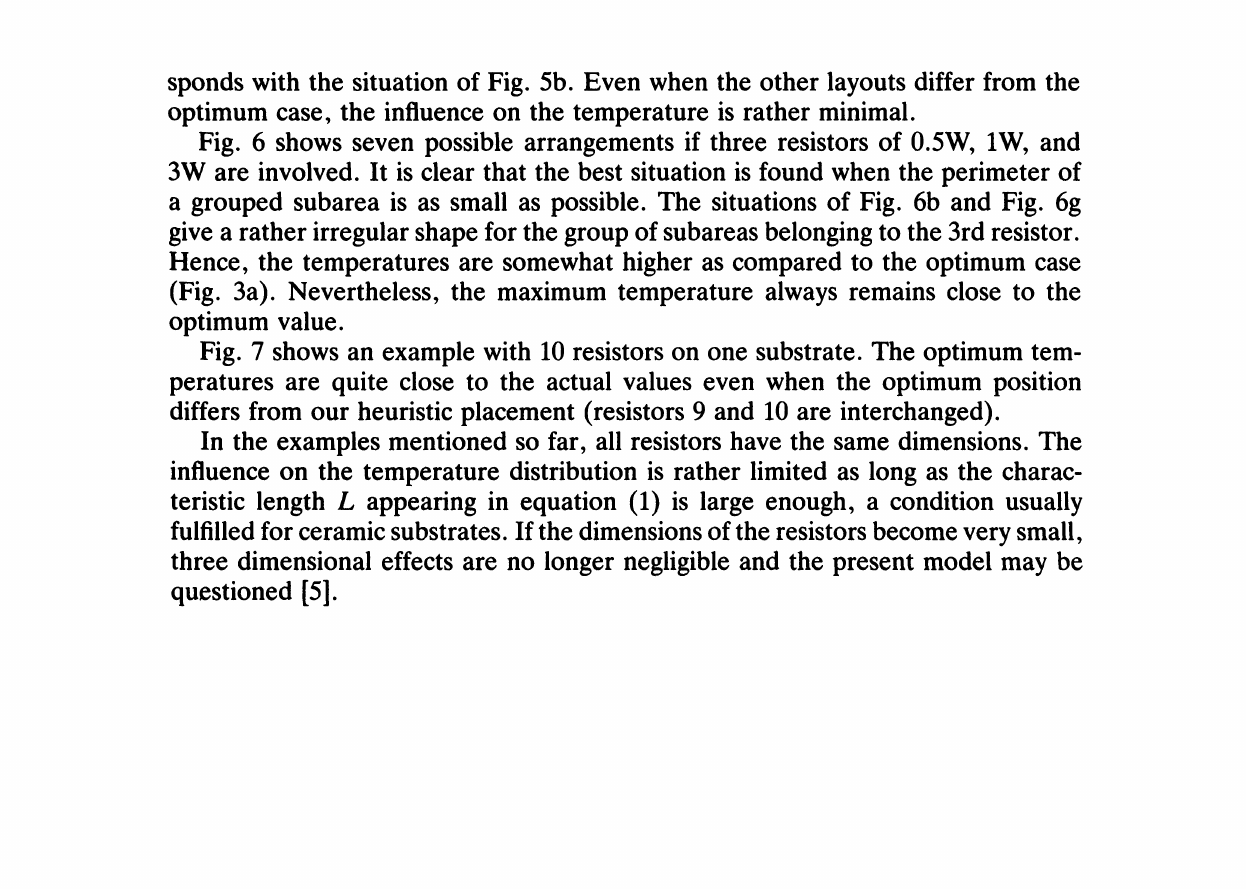
c o=30mm s=O.6mm /=5mm = 155. 3 T1. O PT = I72.2’ T2, OPT FIGURE 4 Example with two resistors of 0.5W and